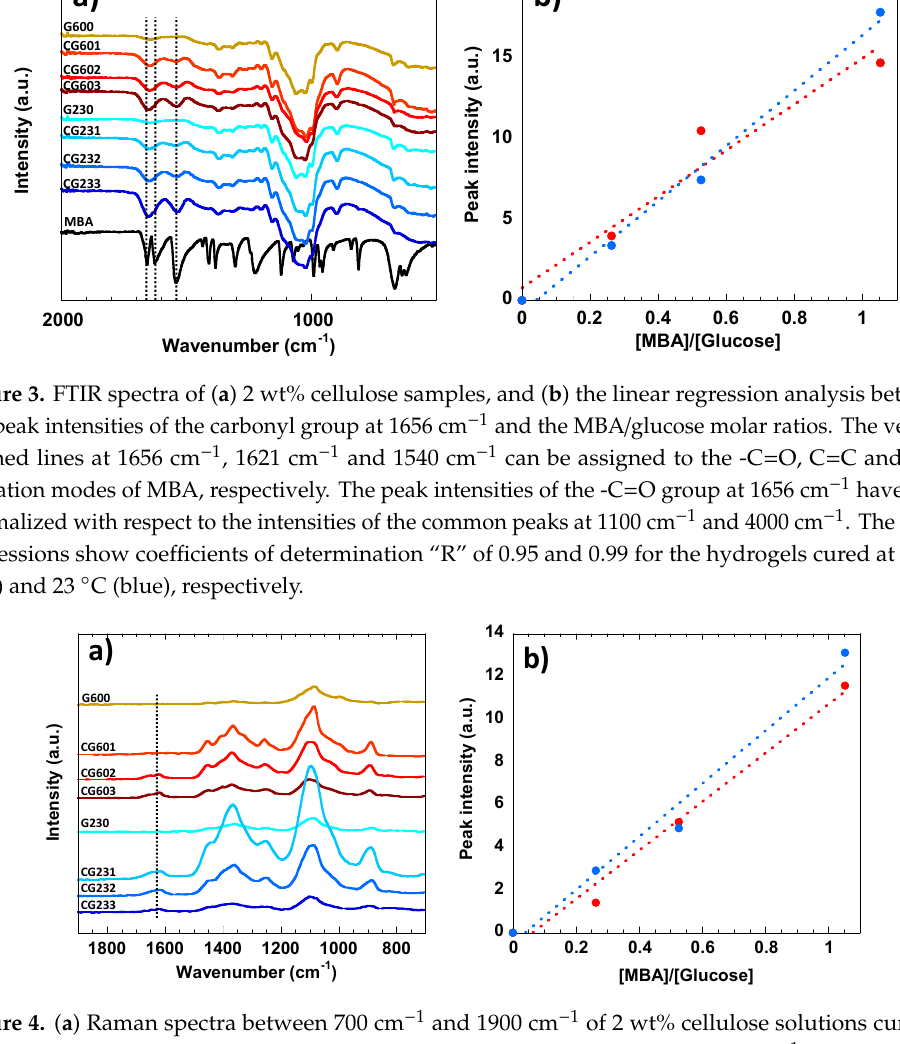
Figure 4. ( a ) Raman spectra between 700 cm − 1 and 1900 cm − 1 of 2 wt% cellulose solutions cured at 60 °C and 23 °C and with different MBA contents. The vertical dashed line at 1621 cm − 1 can be assigned to the –C=O vibration mode from the MBA. ( b ) Linear regression analysis between the peak intensities of the carbonyl group at 1621 cm − 1 and the MBA/glucose molar ratios. The linear regressions show coefficients of determination “R” of 0.98 for the hydrogels cured both at 60 °C for 30 min (red) and 23 °C for 12 h (blue).